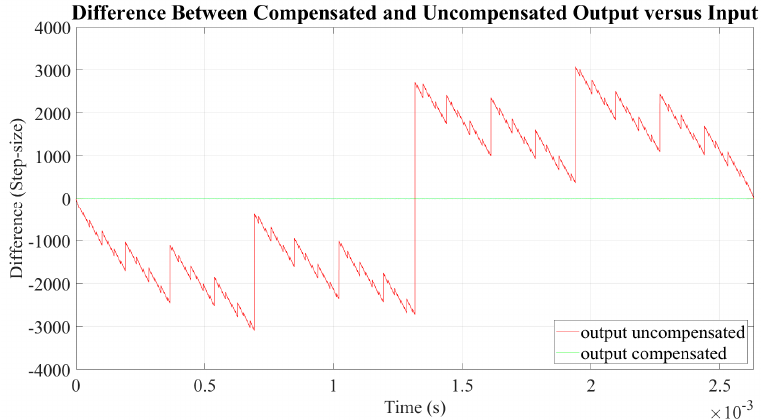
Figure 15. Difference between the input and output of a 16-stage TM-ADC, before and after Figure 15. Di ff erence between the input and output of a 16-stage TM-ADC, before and after compensation, when µ = 1.9. compensation, when µ =